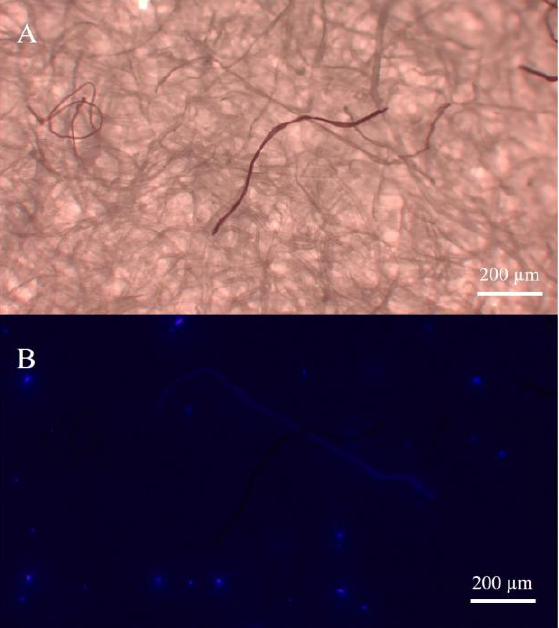
Figure 1. Microscopy images of a filter with fibers isolated from a soft drink before ( A ) and after ( B ) labeling with PBN. Only the plastic fiber emitted electric blue fluorescence.